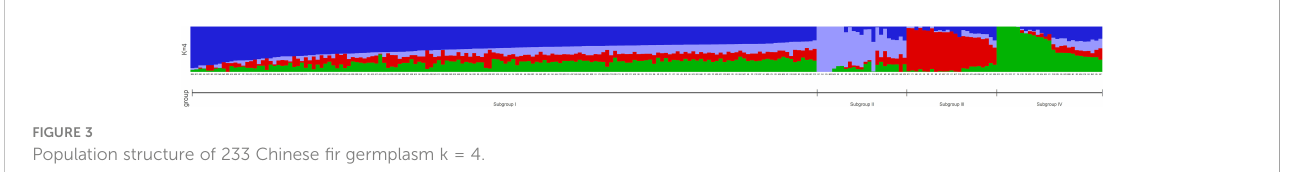
FIGURE 3 Population structure of 233 Chinese fi r germplasm k = 4.